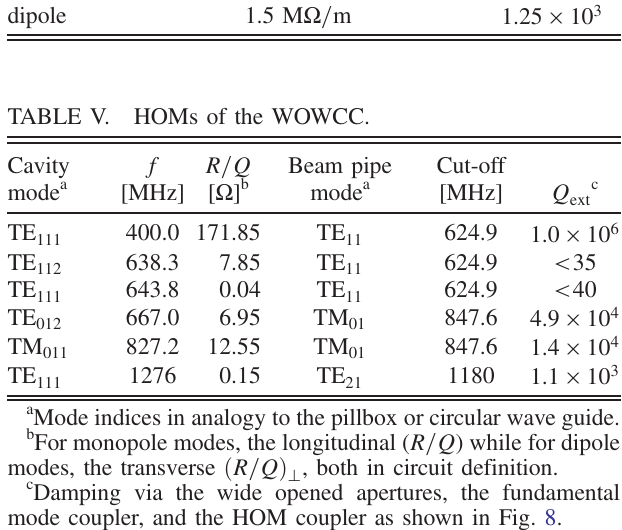
TABLE IV. Max. required Q